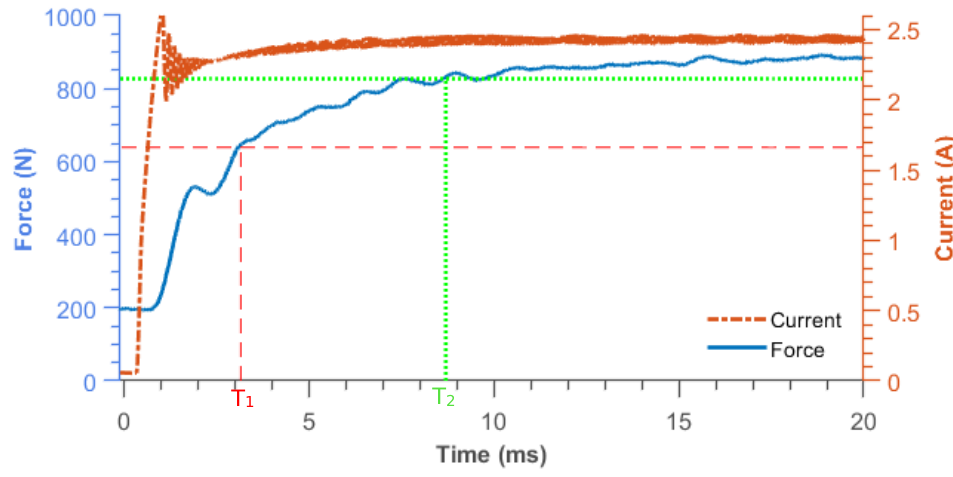
Figure 5. Response time of the damper (red line — T 1 , green line — T 2 ).